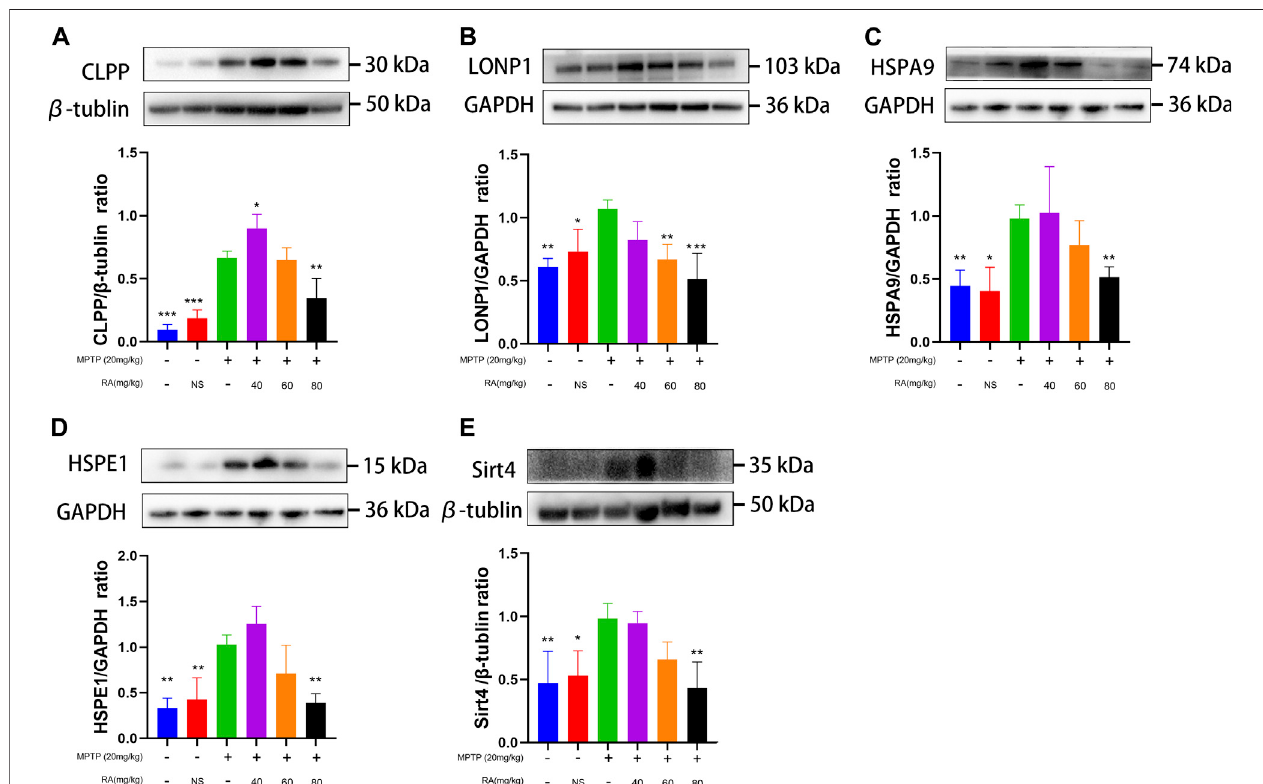
FIGURE 6 | RA alleviated MPTP-induced mitochondrial damage via the mtUPR in MPTP-mice. MPTP caused a signi fi cant increase in CLPP (A) , LONP1 (B) , HSPA9 (C) , and HSPE1 (D) expression, and RA reversed these increases in a dose-dependent manner. RA regulated SIRT4 (E) expression in MPTP-mice. The expression of SIRT4 increased by MPTP administration, and RA reversed this increase in a dose-dependent manner. Data are expressed as mean ± SD. One-way analysisofANOVA withTukey'stest wasused in CLPP, LONP1, HSPE1, and Sirt4. One-way analysisofANOVA with Dunnett's T3test wasused inHSPA9.